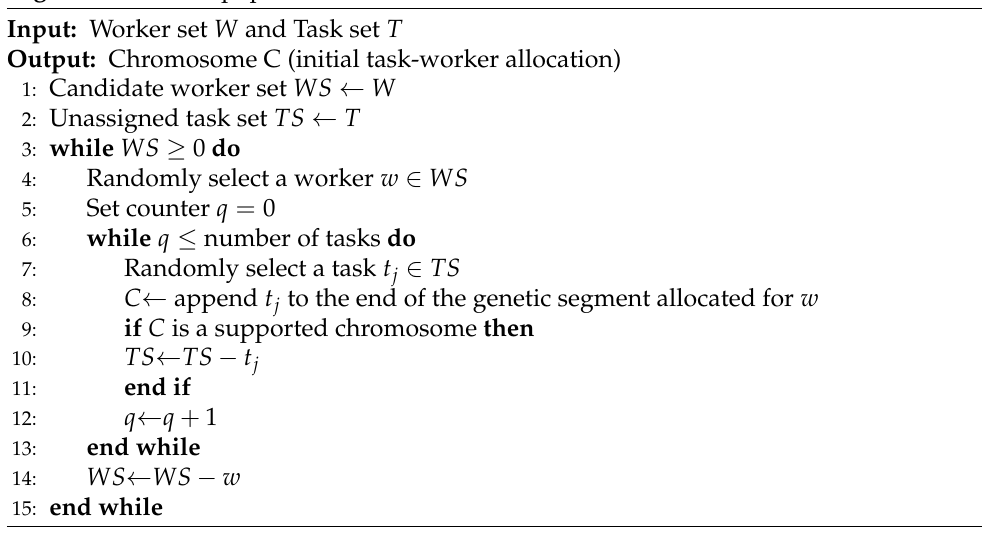
Algorithm 2 Initial population.